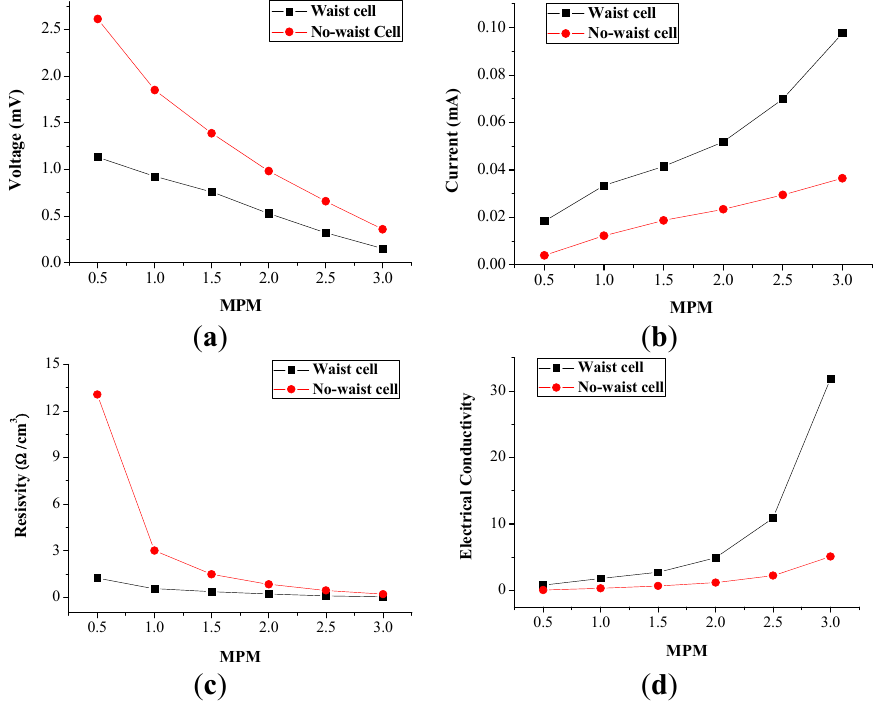
Figure 6. Performance comparison of the waisted and no-waisted cells due to potassium concentration (the current and voltage data for each given MPM is to average the measured data with about 1.2 h): ( a ) current; ( b ) voltage; ( c ) resistivity; and ( d )